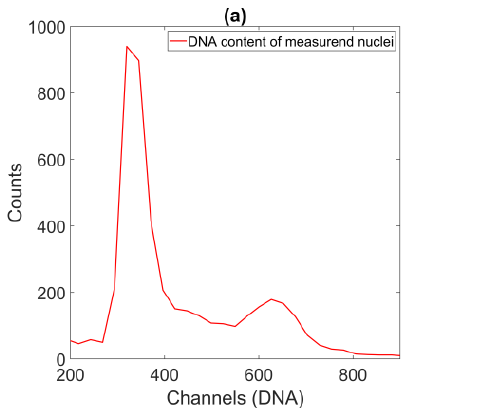
Figure 2. FCM ( a ) and ICM DNA content ( b ) histograms of one of the samples. Both x -axis values are intensity sums: in the FCM case, the maximal integral recorded at the detector during a nucleus passthrough; in the ICM case, the sum of the pixel intensities belonging to the segmented nucleus region (corrected by approximated background intensity). The dual peaks typical of samples from healthy donors are identifiable on the plots of both